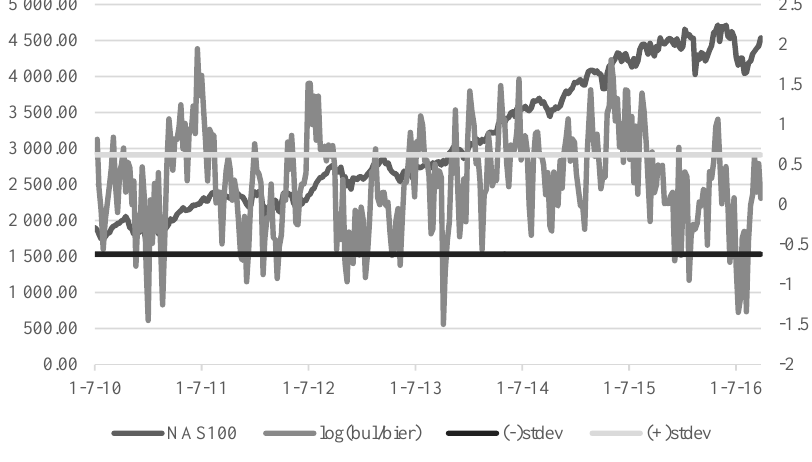
Figure 4. Dynamic of historical data for individual investors’ sentiments (AAII) and the NAS100 index